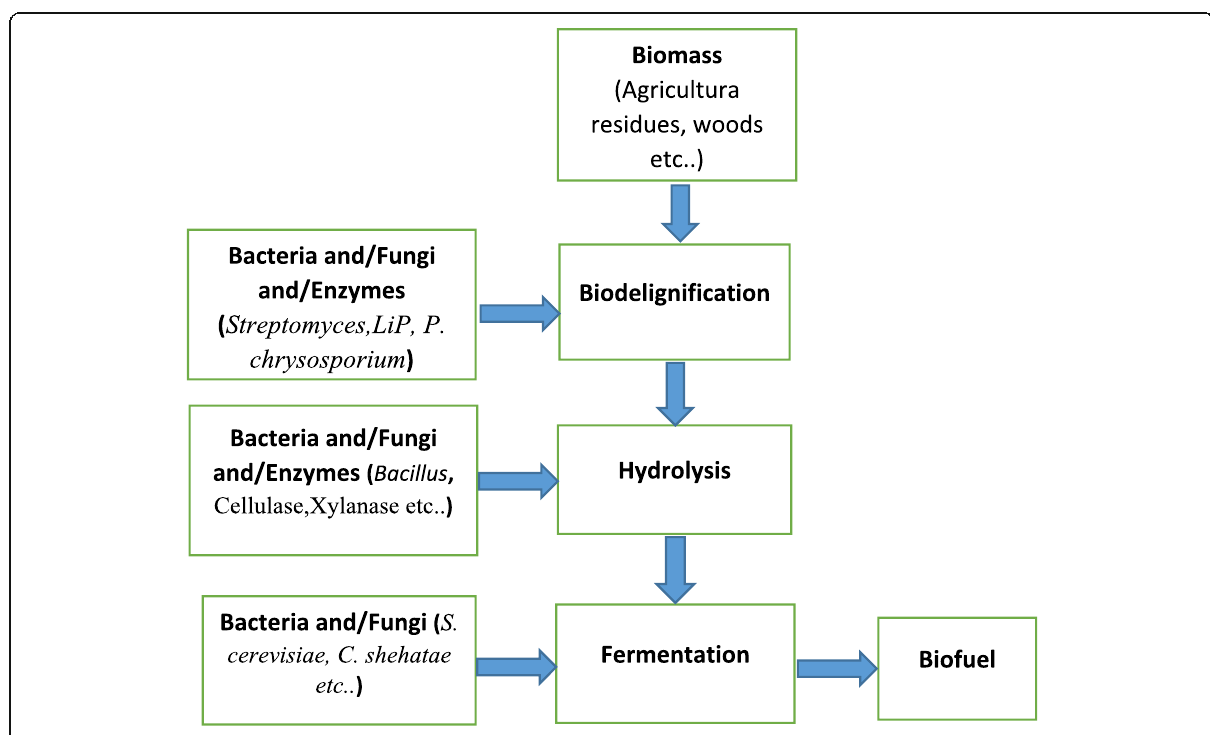
Fig. 1 Overall biological conversion scheme of lignocellulose biomass to